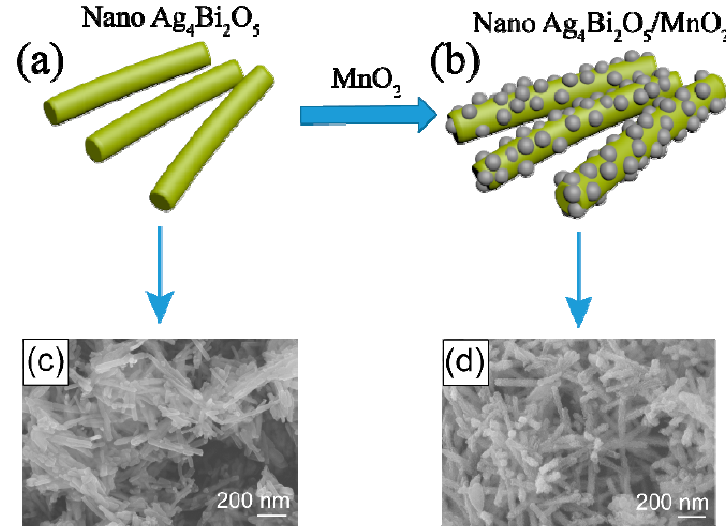
Figure 1. Schematic drawing of the synthesis process of nano Ag 4 Bi 2 O 5 /MnO 2 material. ( a ) diagram of nano Ag 4 Bi 2 O 5 ; ( b ) diagram of nano Ag 4 Bi 2 O 5 /MnO 2 ; ( c ) SEM image of nano Ag 4 Bi 2 O 5 ; ( d ) SEM image of nano Ag 4 Bi 2 O 5 .